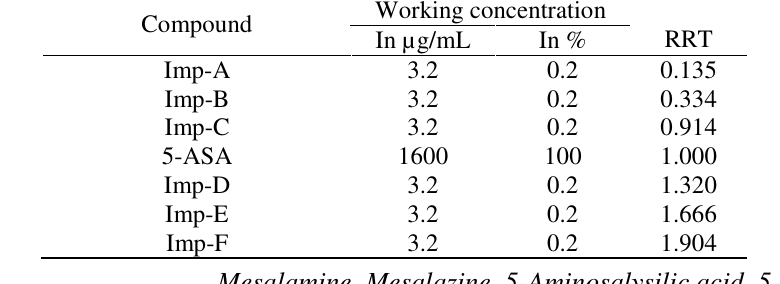
Table 1. Name of the impurities, working concentration (in % and µg/mL) and related retention time (RRT) with respect to mesalamine (5-ASA) are as